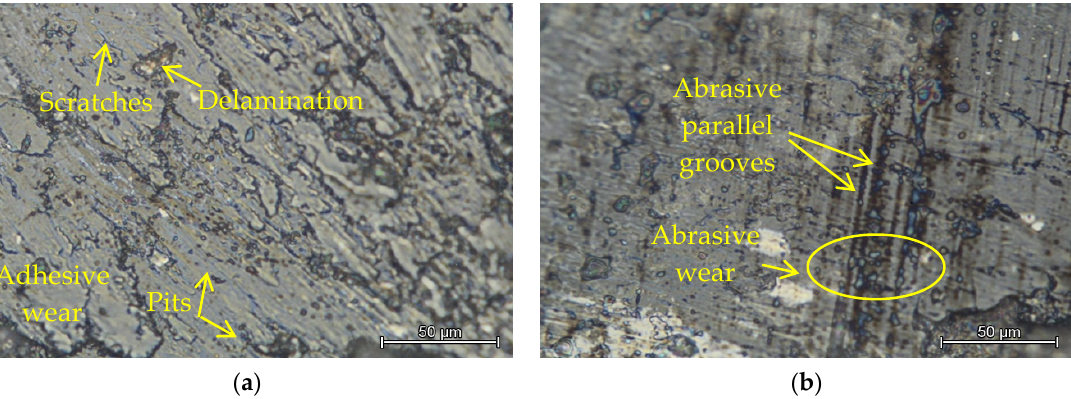
Figure 13. Wear analysis of worn surfaces Al 2 O 3 with contact: ( a ) M390_200 and ( b ) M398_600DF.